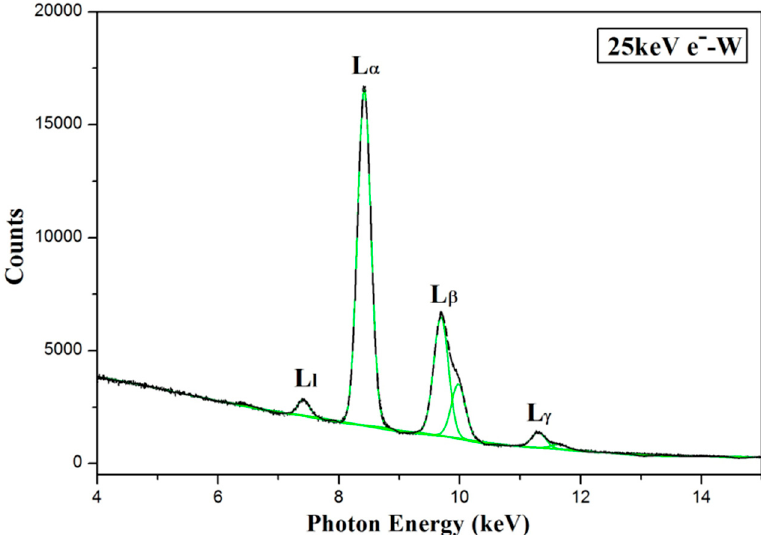
Figure 2. Photon spectra showing fitting of the bremsstrahlung background and that of characteristic tungsten L X-ray lines produced from 25 keV electrons incident on W at α = 45° using the Gaussian multiple-peak fitting procedure (green line curves). Due to limited resolution of the detector, L α , L β and L γ lines are not resolved.